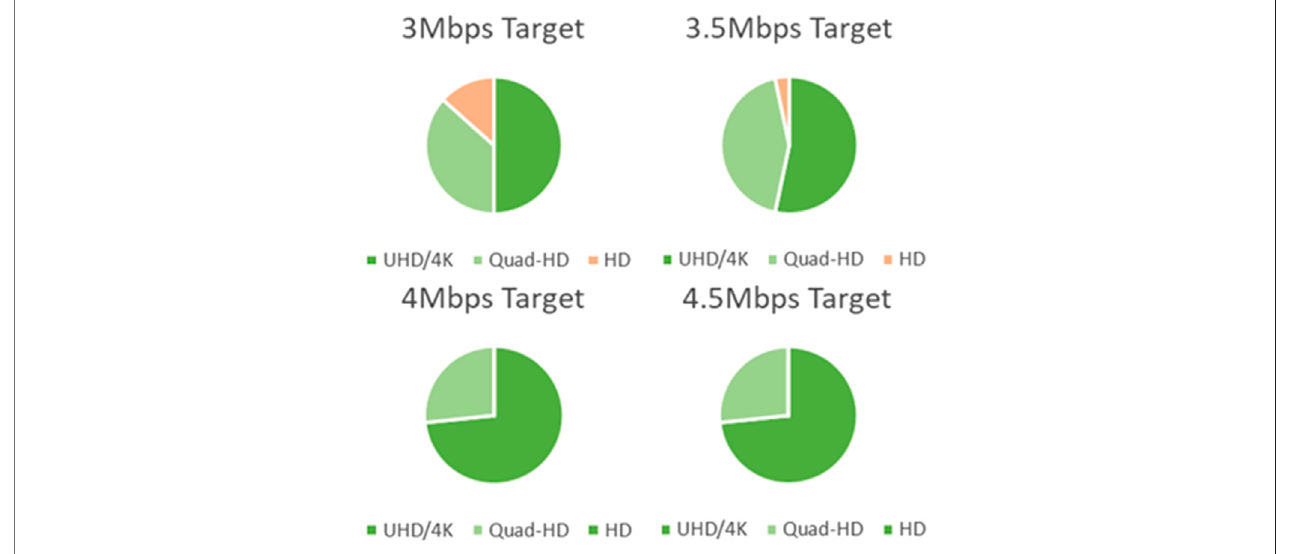
FIGURE 17 | Selected resolution for LCEVC-enhanced streams using the soft-threshold DRE approach